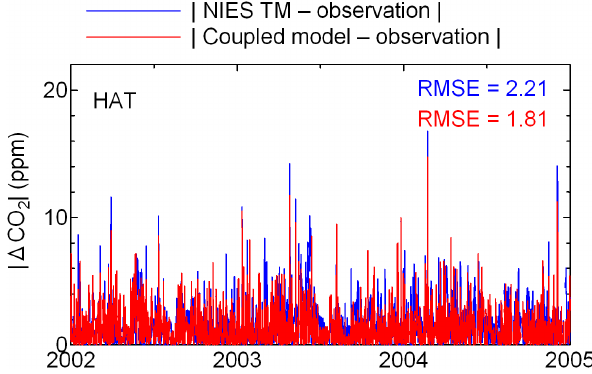
Figure 3. Absolute value of the difference between deseasonalized model-simulated and Fig. 3. Absolute value of the difference between deseasonalized observed CO 2 concentrations at Hateruma. Blue lines: NIES TM minus observations; red model-simulated and observed CO 2 concentrations at Hateruma. lines: coupled model minus observations. Root mean square error (RMSE) is shown in the Blue lines: NIES TM minus observations; red lines: coupled model figure. Blue: NIES TM; red: coupled model. minus observations. Root mean square error (RMSE) is shown in the figure. Blue: NIES TM; red: coupled model.